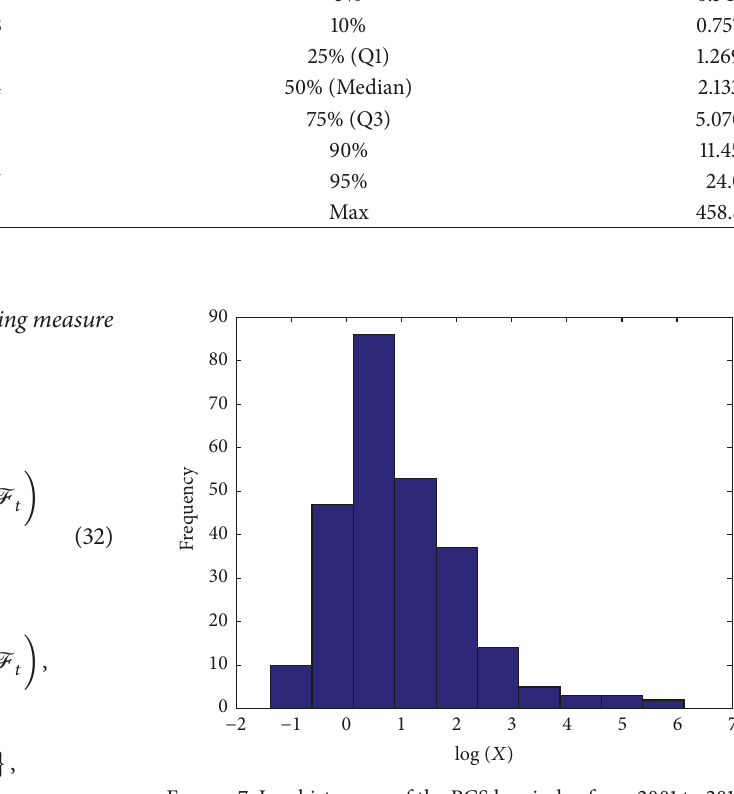
Figure 7: Log histogram of the PCS loss index from 2001 to